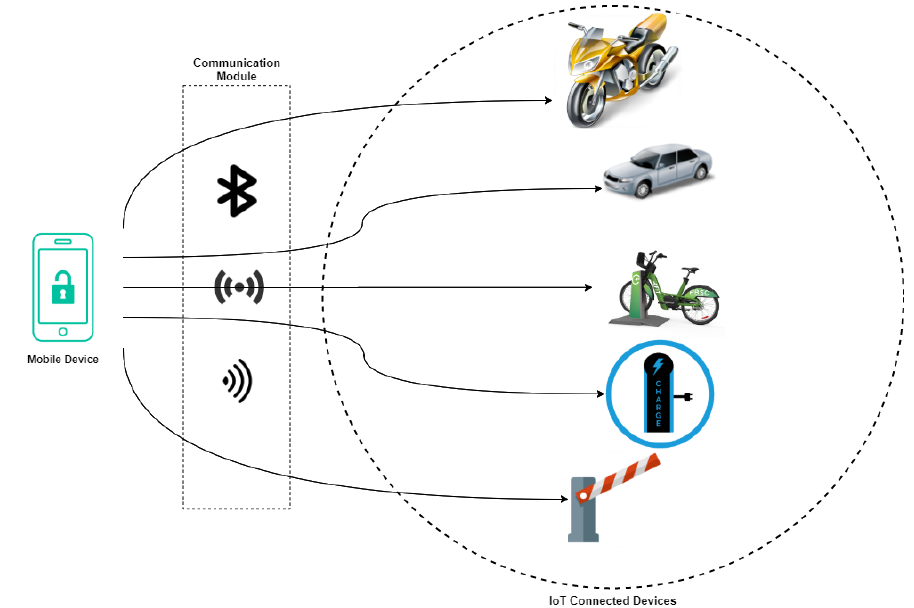
Figure 1. Smartphone-centric vehicle control, monitoring, and security